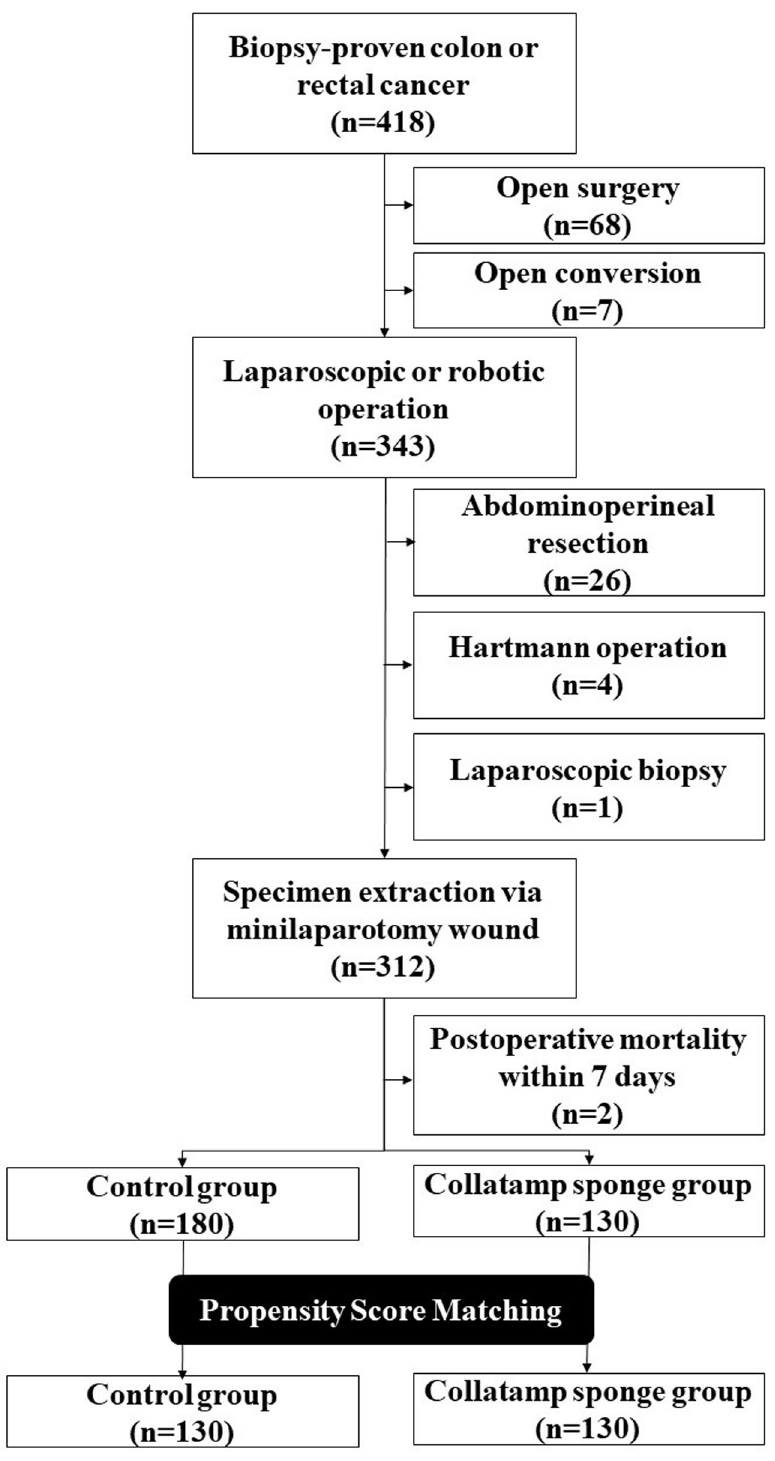
Fig 1. Flowchart of patient